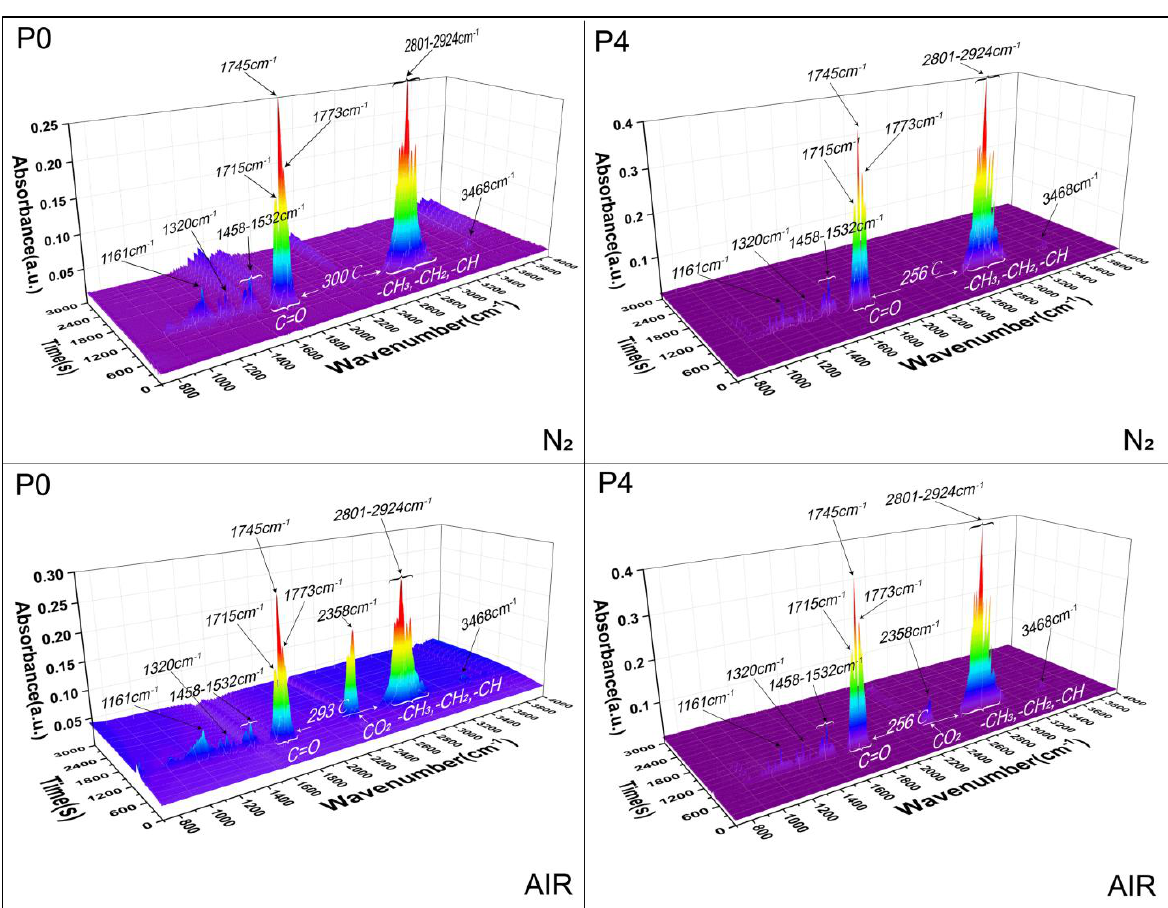
Figure 14. TG-IR 3D diagrams of P0 and P4 composites in N 2 and AIR atmospheres, respectively.